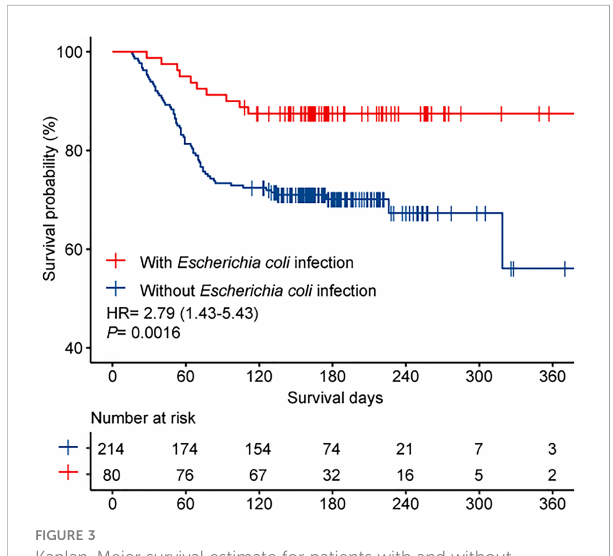
FIGURE 3 Kaplan-Meier survival estimate for patients with and without Escherichia coli infection.